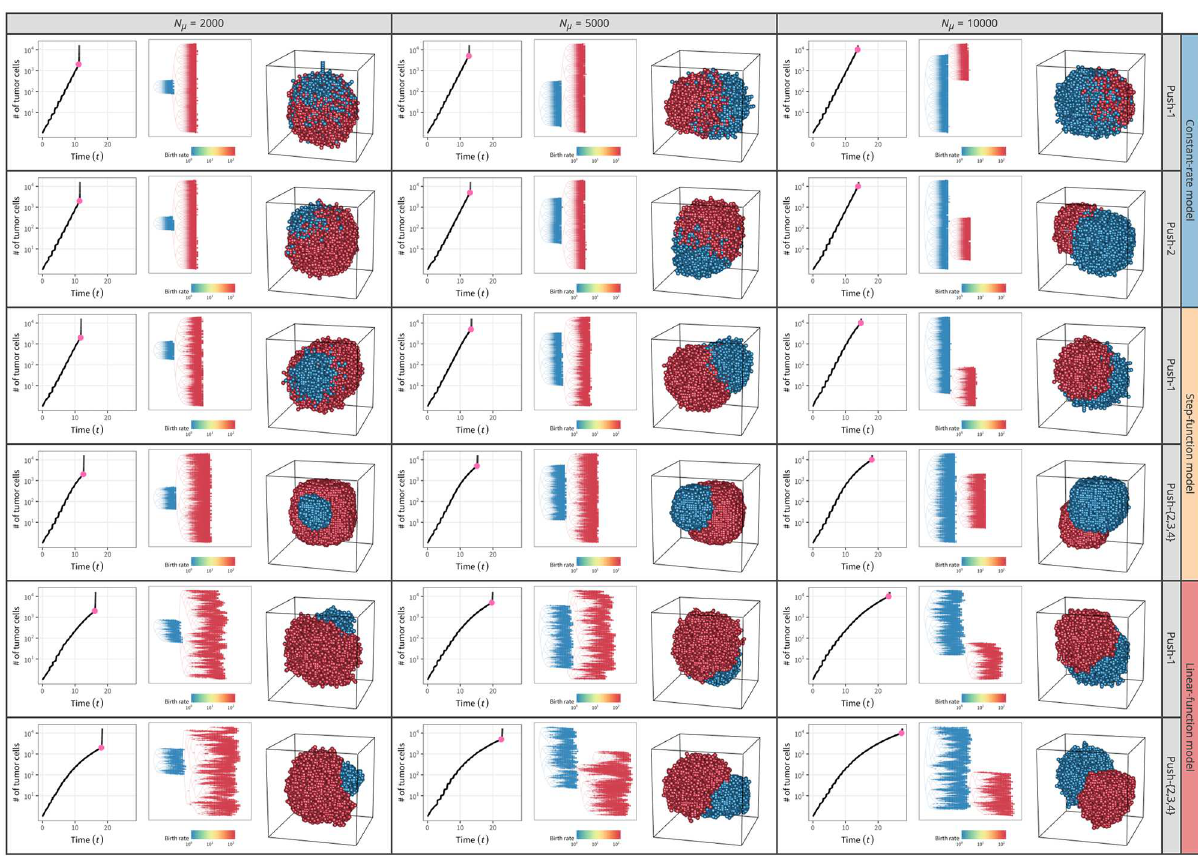
Fig 13. 3D structuresof simulated tumors with a single strong driver mutation. Results for push methods1 and 2 under constant-rate, step-function, and linear-function models are shown. The cells with the string driver mutation ( s β = 99) are in red, whilethe others are in blue. The results for one simulationrun are shown for each setting. The time point when the driver mutation was introduced is shown by a pink circle on the growth curve.